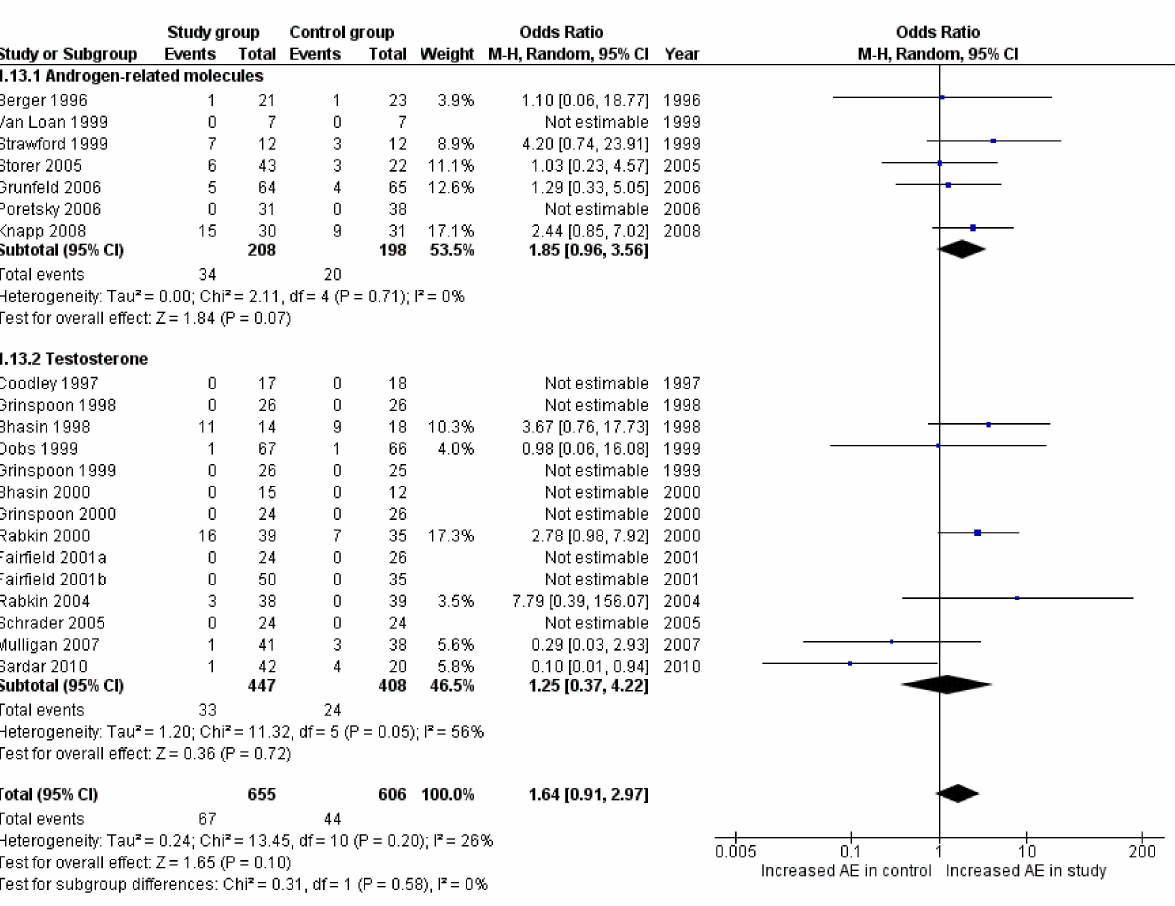
Figure 6. Forest plot reporting drop out occurrence between study and control groups detected in the second literature